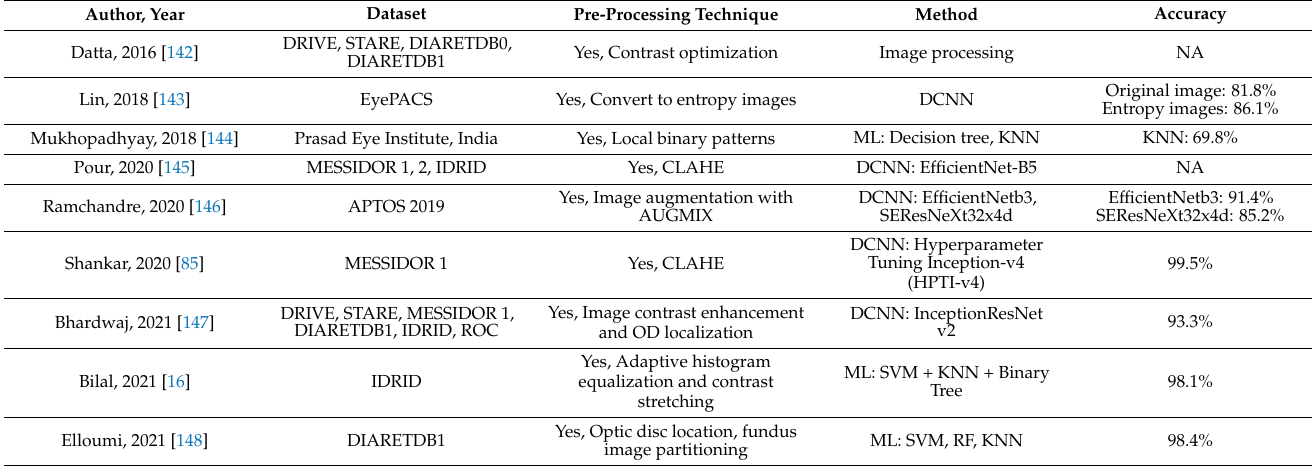
Table 3. Classification-based studies in DR detection using a special preprocessing on fundus images for DR grading in ICDR